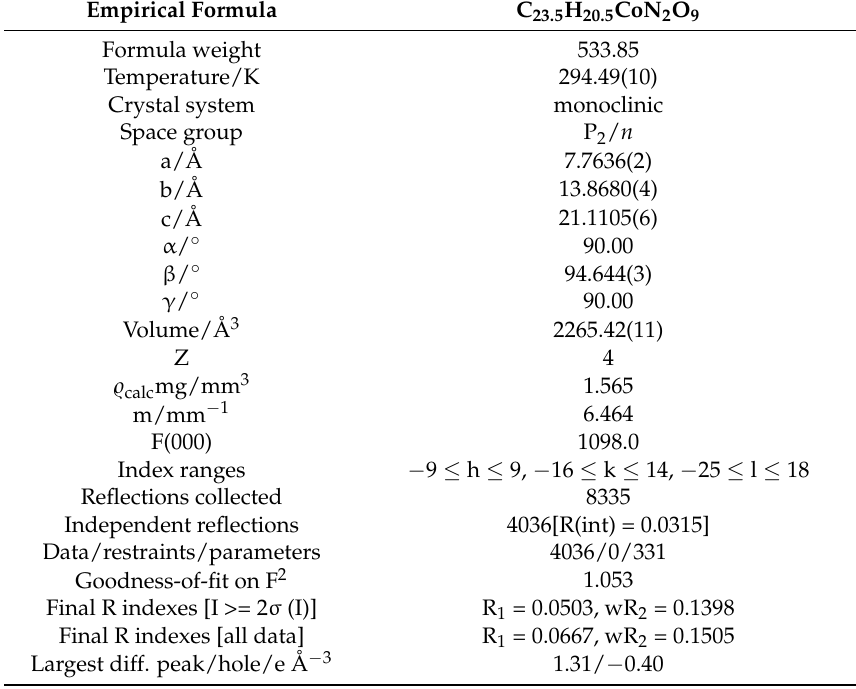
Table 1. Crystal data for complex 1 .